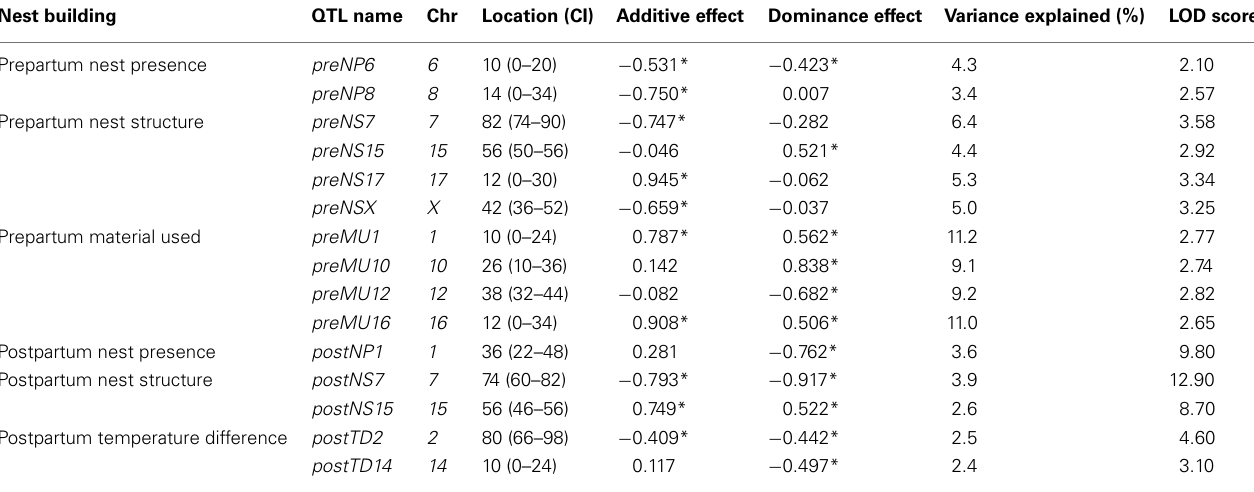
Table 2 | Direct-effect QTLs of pre- and postpartum nest building phenotypes in F 2 females in maternal phase. Nest building